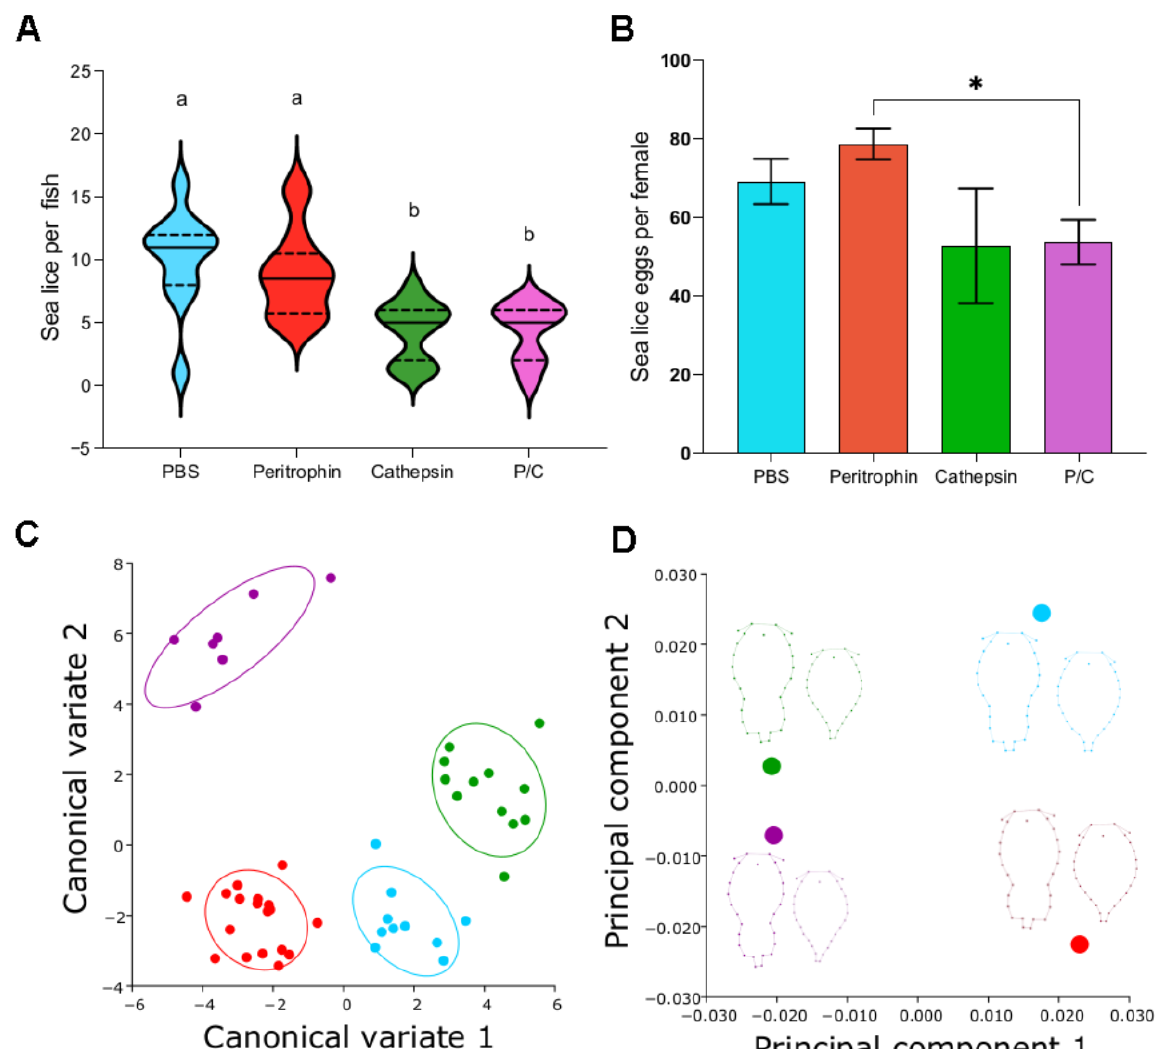
Figure 7. Effect of exposure of C. rogercresseyi to fish injected with vaccine prototypes. Treatments differentiated by colors: PBS control group in blue, peritrophin-vaccinated group in red, cathepsin- vaccinated group in green, and P/C-vaccinated group in purple. ( A ) The violin plots represent adult C. rogercresseyi bunder per fish in each experimental group. Lowercase letters indicate significant differences between groups at a p -value < 0.05. ( B ) Columns represent the median of females ’ eggs per treatment, and the error bars represent the SEM. Asterisks indicate significant differences with a p -value < 0.05. ( C ) Morphometric analysis per canonical variables of experimental groups. ( D ) Principal components analysis of female and male morphotypes. In addition, the average morphotype figure for each group is